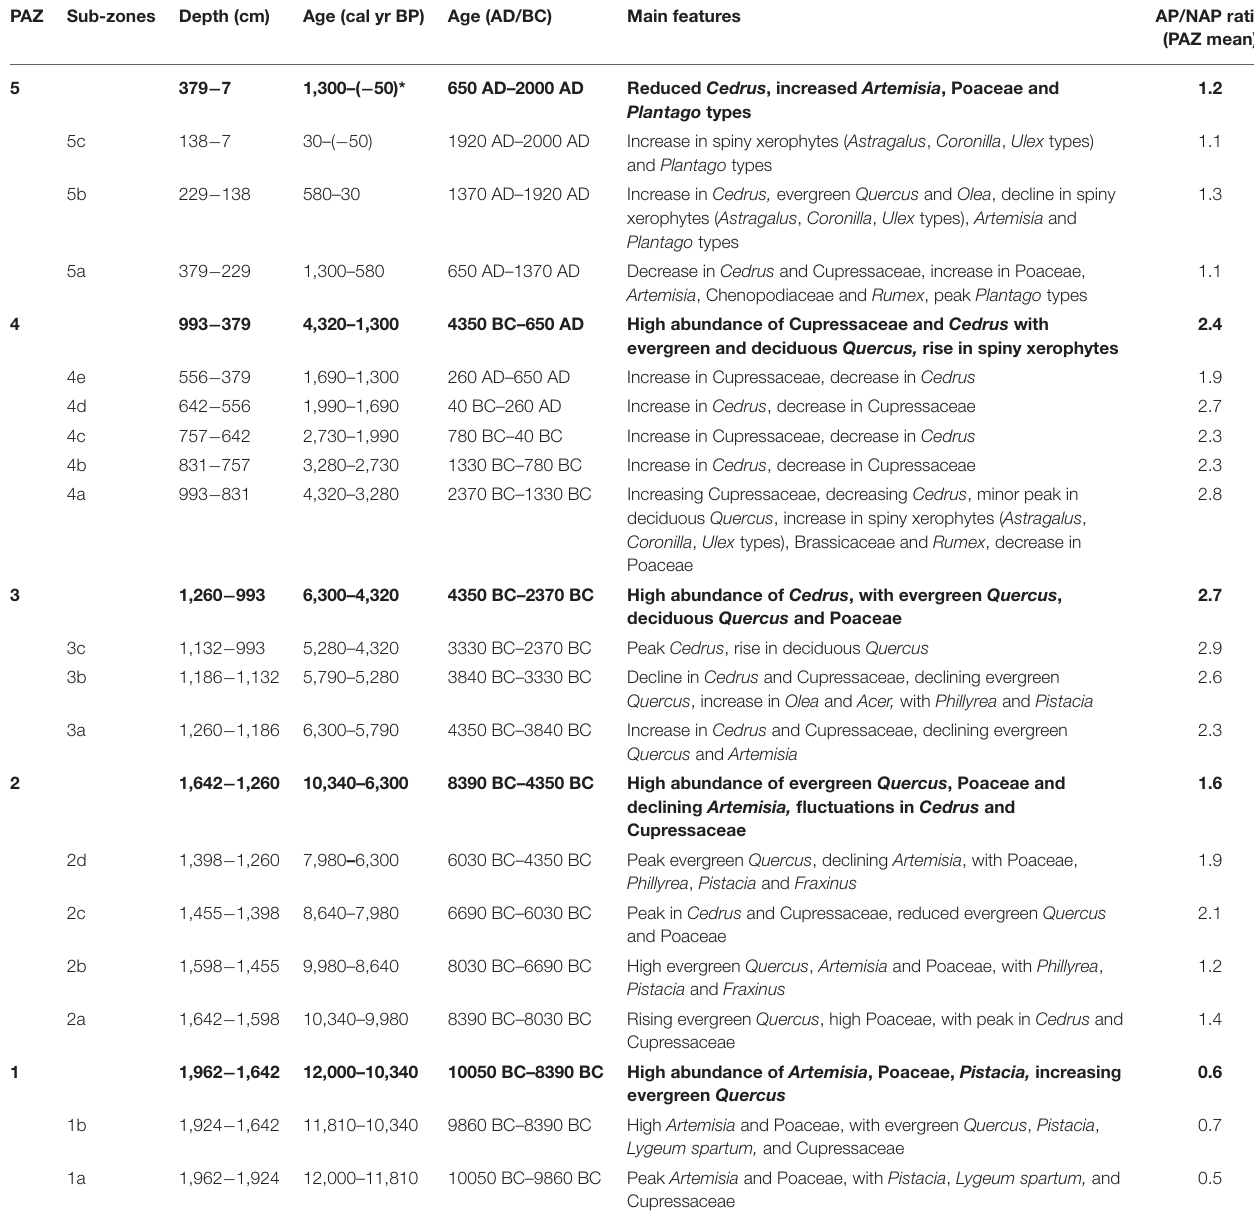
TABLE 1 | Definition and main characteristics of the pollen assemblage zones (PAZs) (boldface) and sub-zones for cores ALI 01–10. PAZ Sub-zones Depth